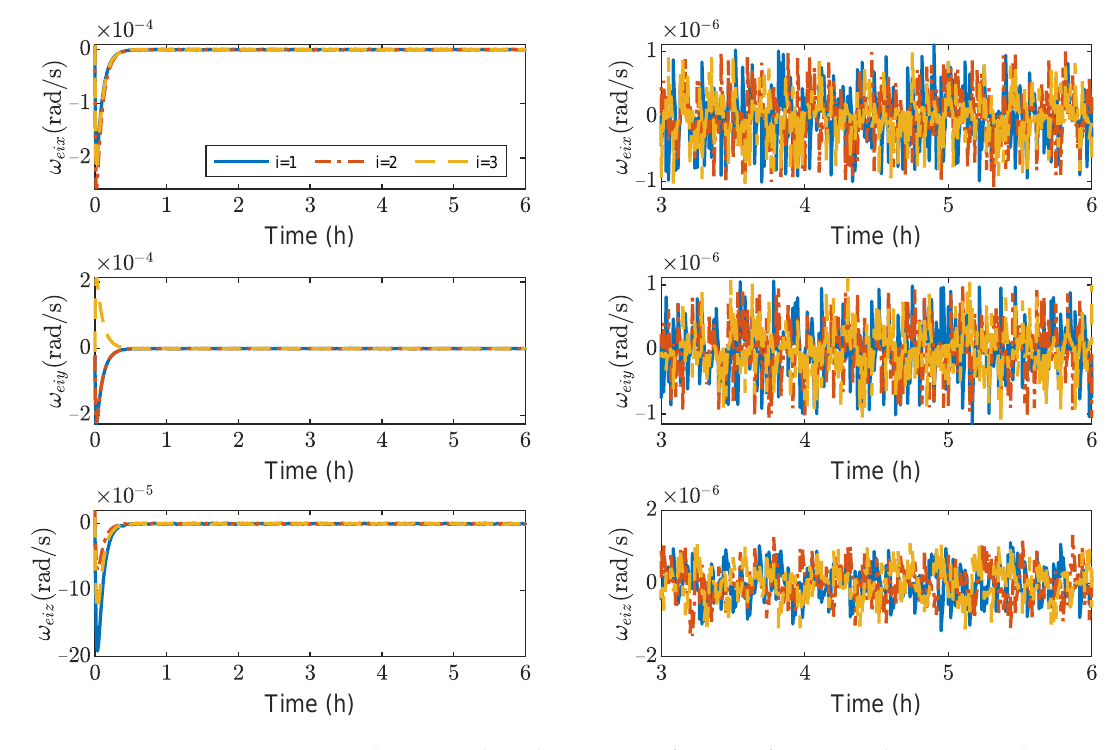
Figure 15. Relative angular velocity errors of spacecraft SC1 ∼ 3, the max control torque of spacecraft is 100 mN · m.